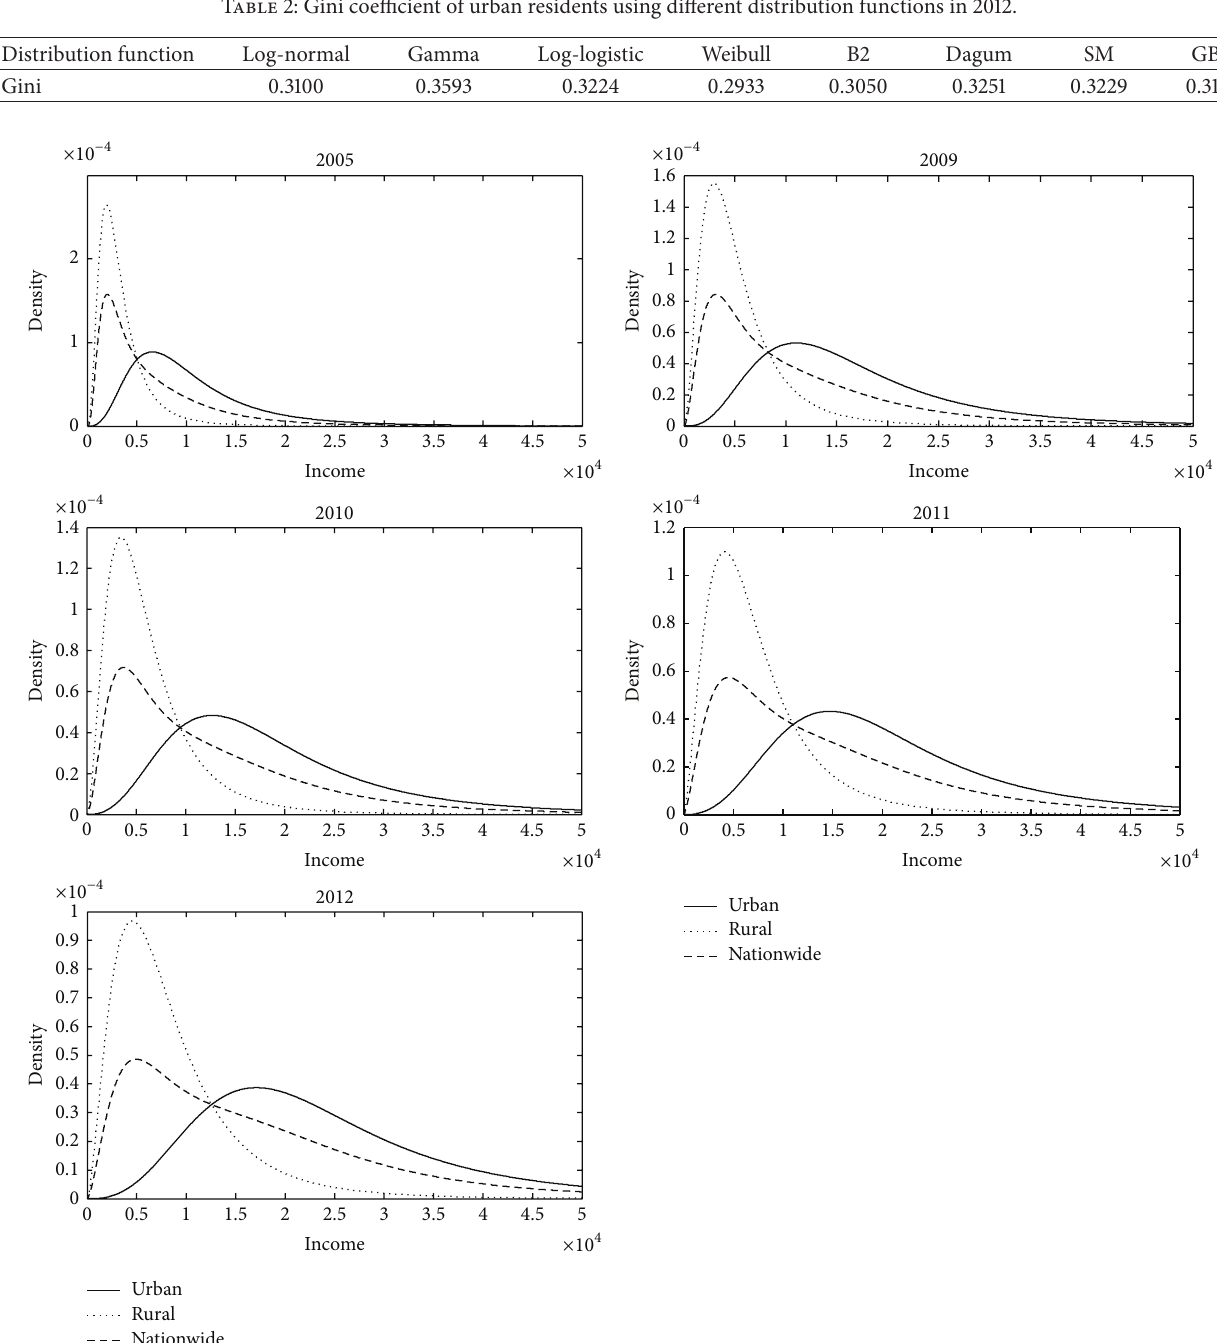
Figure 2: Income distribution of rural, urban, and national residents from 2005 to